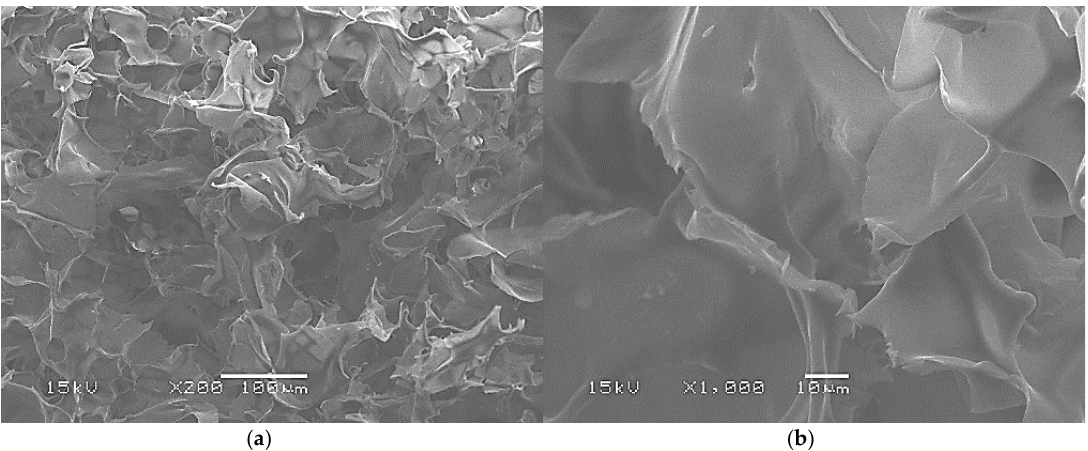
Figure 5. Dry lyophilized starch raw material SEM micrographs: ( a ) × 200; ( b ) × 1000.